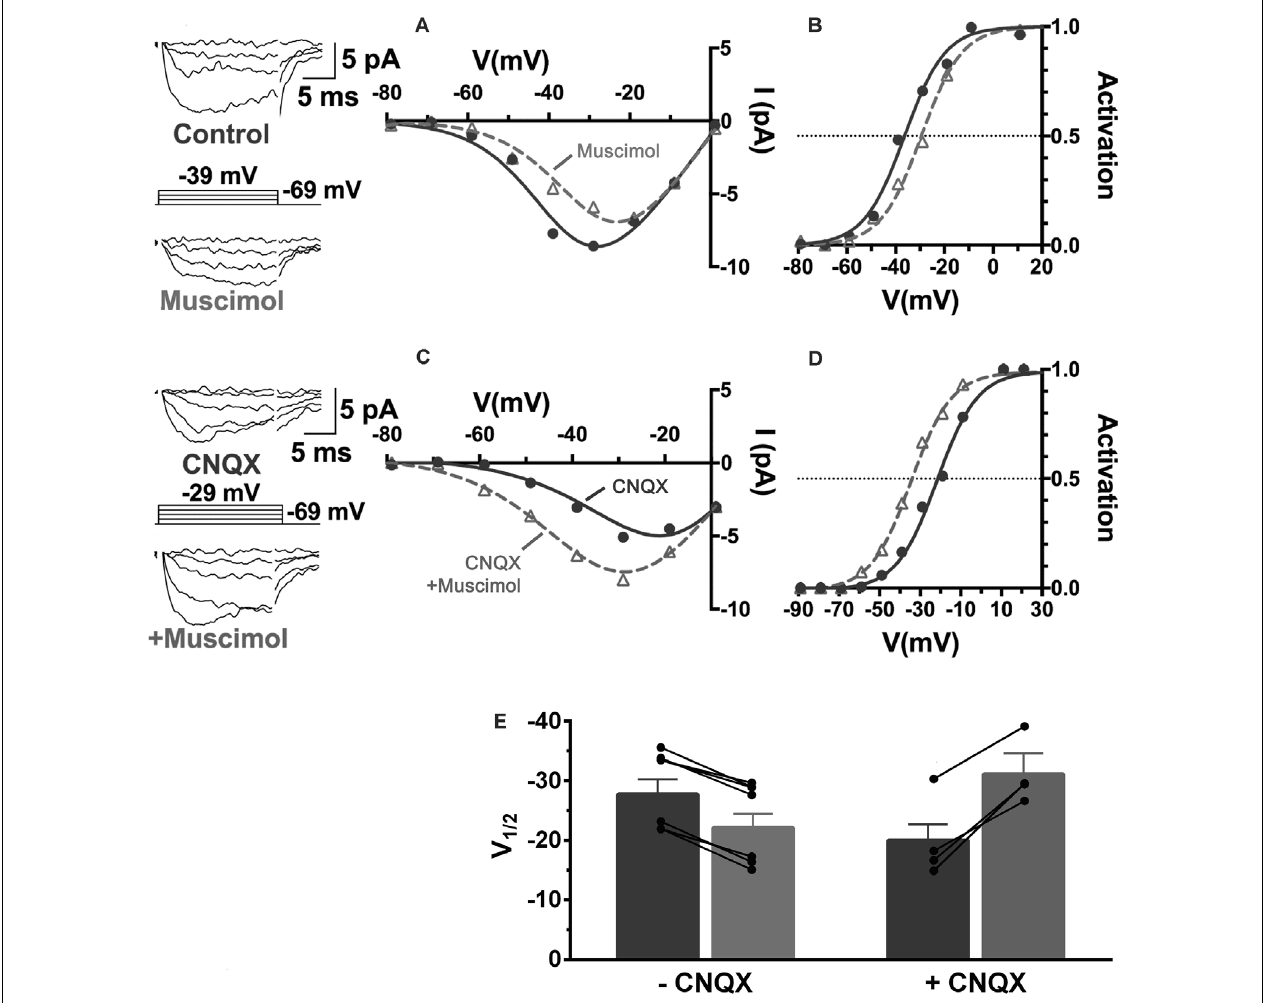
FIGURE 11 | The sign of GABA’s influence on feedback is dependent on the horizontal cell membrane potential. Ca V currents in cones are inhibited or disinhibited by muscimol depending on whether CNQX is present to block glutamatergic input to horizontal cells. (A) I–V relations show smaller cone Ca V currents during muscimol superfusion in the absence of CNQX, due to Ca V channel activation curve shifting 7 mV positive (B) during muscimol application. (C) In the presence of CNQX, which hyperpolarizes cones, muscimol shifted activation curve V 1 to a more negative voltage (D) , leading to larger currents at all membrane potentials. 2 (E) Changes to cone Ca V channel activation curve midpoint caused by muscimol with or without the presence of CNQX show that the effect of muscimol depends on horizontal cell membrane potential as controlled by glutamate. Figure modified from Grove et al.